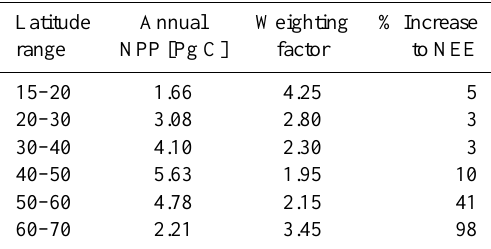
Table 2. Scale factors used to increase Northern Hemisphere net primary productivity (NPP) by 25% in CASA.